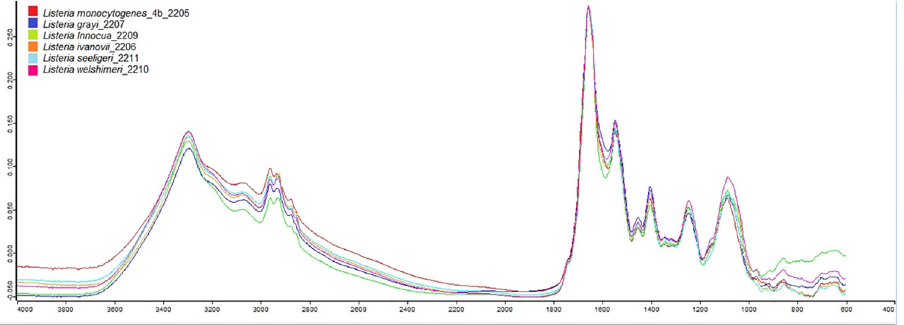
Fig 1. Raw FT-IR data of six Listeria species. L . monocytogenes , L . grayi , L . innocua , L . ivanovii , L . seeligeri , L . welshemeri .